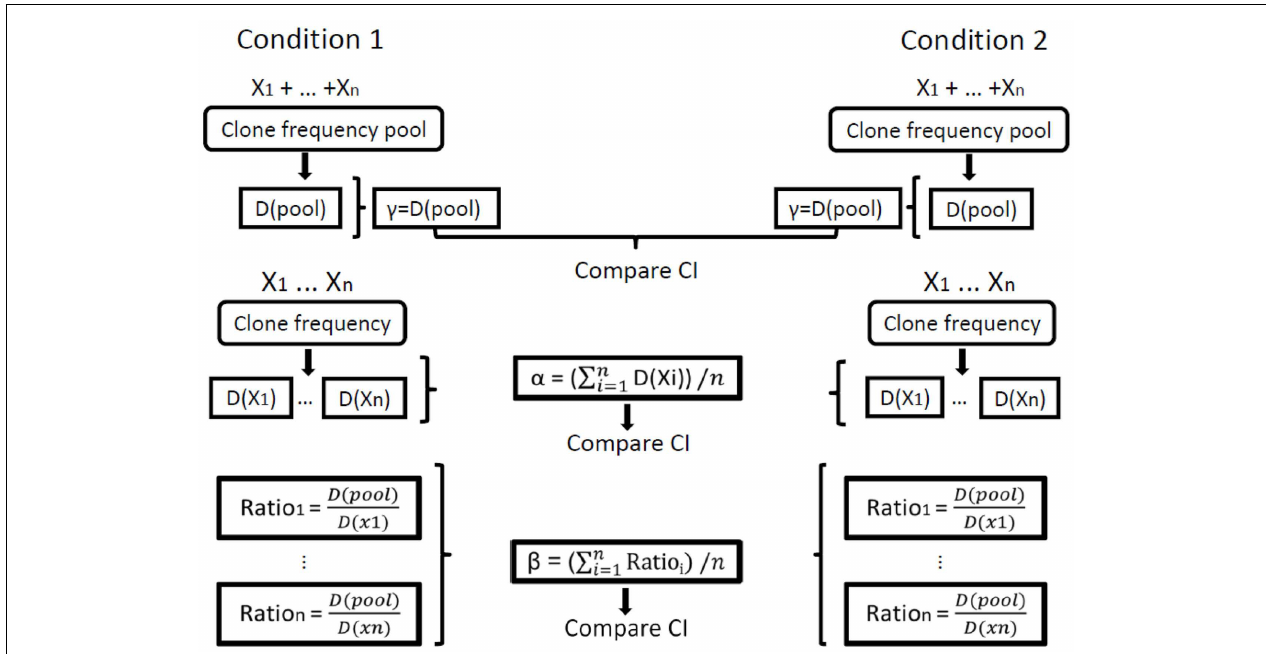
sample i , that is, the set (for all samples) of the numbers of unique sequences in all clones in sample i out of the total number of unique sequences in the whole sample. D stands for Diversity, D (pool) is the calculation of γ (gamma) for a sample and D (Xi) is the calculation of α (alpha) for sample i . In our calculations of order 1, we used only the Shannon entropy for D, and for order 2 we used only the Simpson concentration for